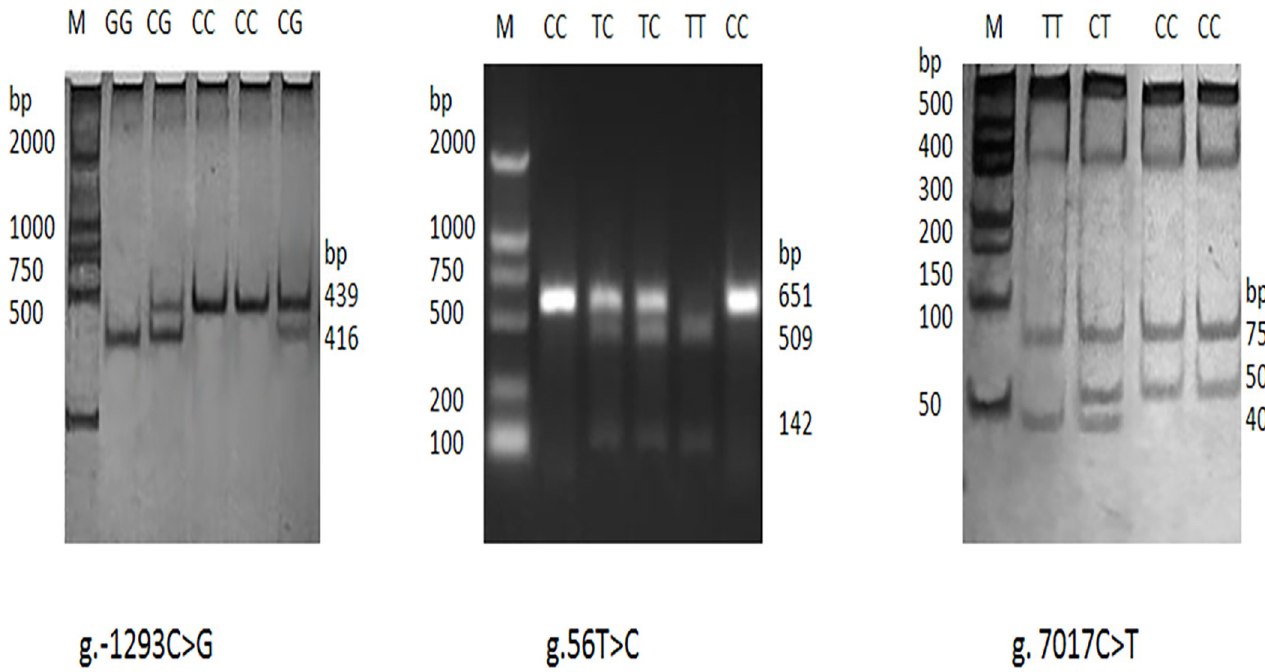
Fig 3. PCR-RFLP detection results of the three new SNPs (g.-1293C > G, g.56T > C, g.7017C > T) in bovine C3 gene.